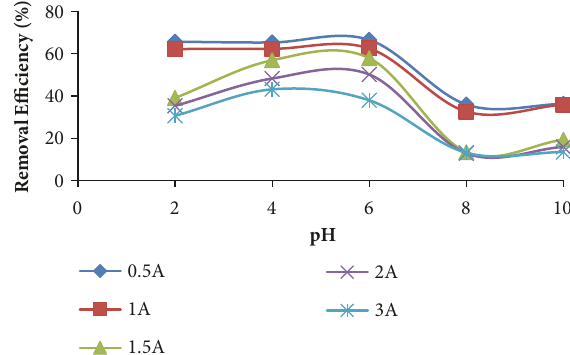
Figure 2: Effect of pH at varying current densities, for POME at 50 ∘ C.